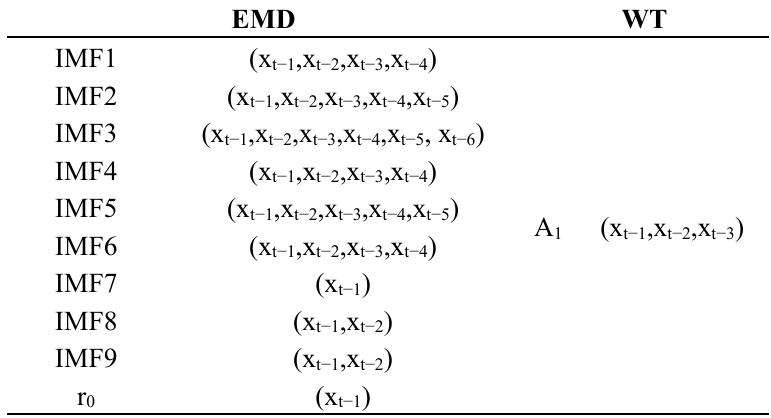
Table 5. Result analysis of PACFs of the wind speed after EMD and WT.